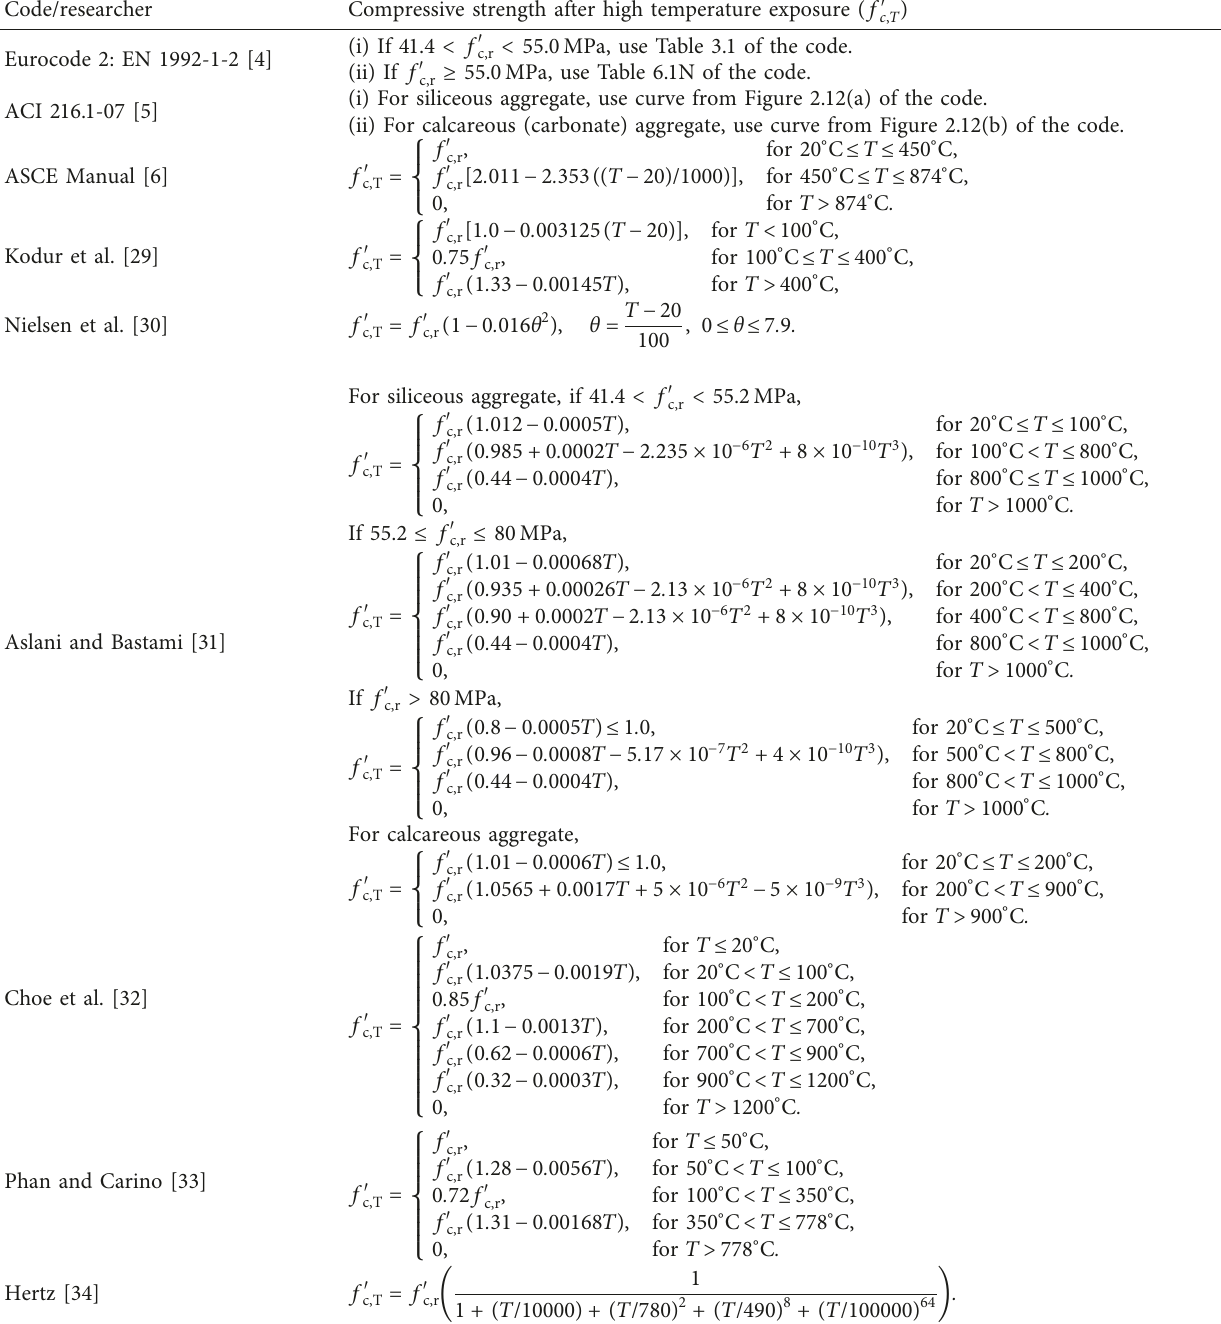
Table 1: Models for residual compressive strength of concrete after high-temperature exposure.